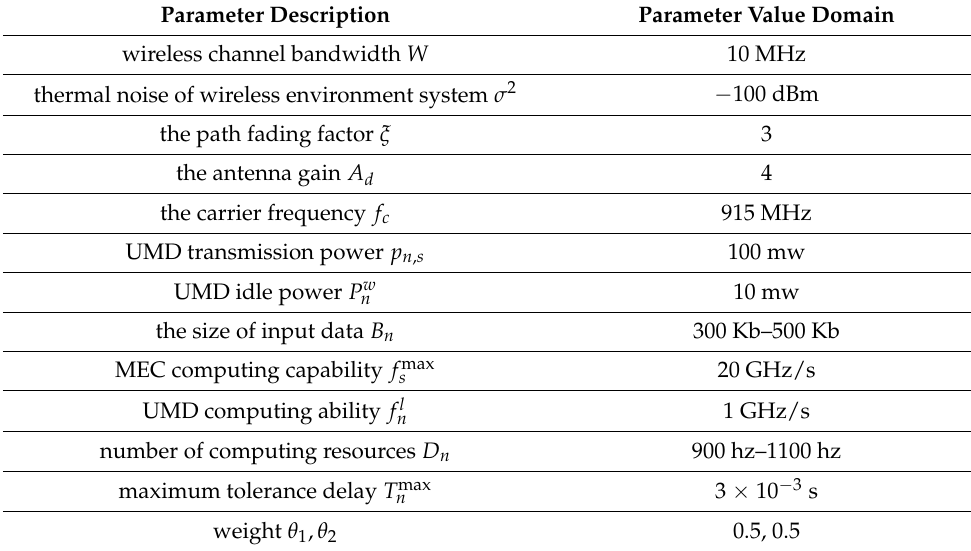
Table 4. The system simulation